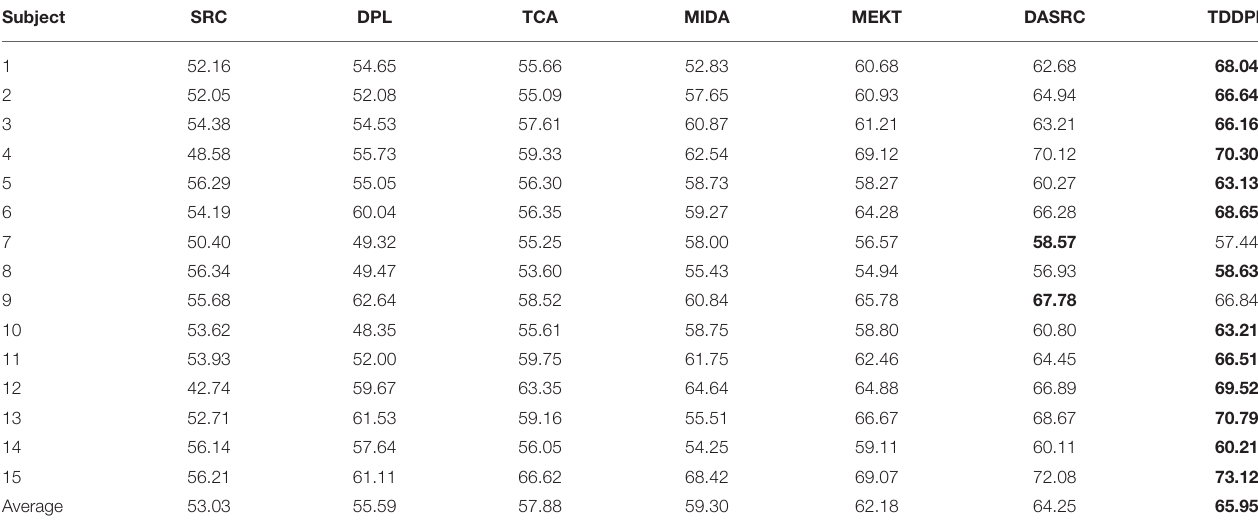
TABLE 2 | Average classification accuracies on session 1 of SEED dataset in the o → o scenario.